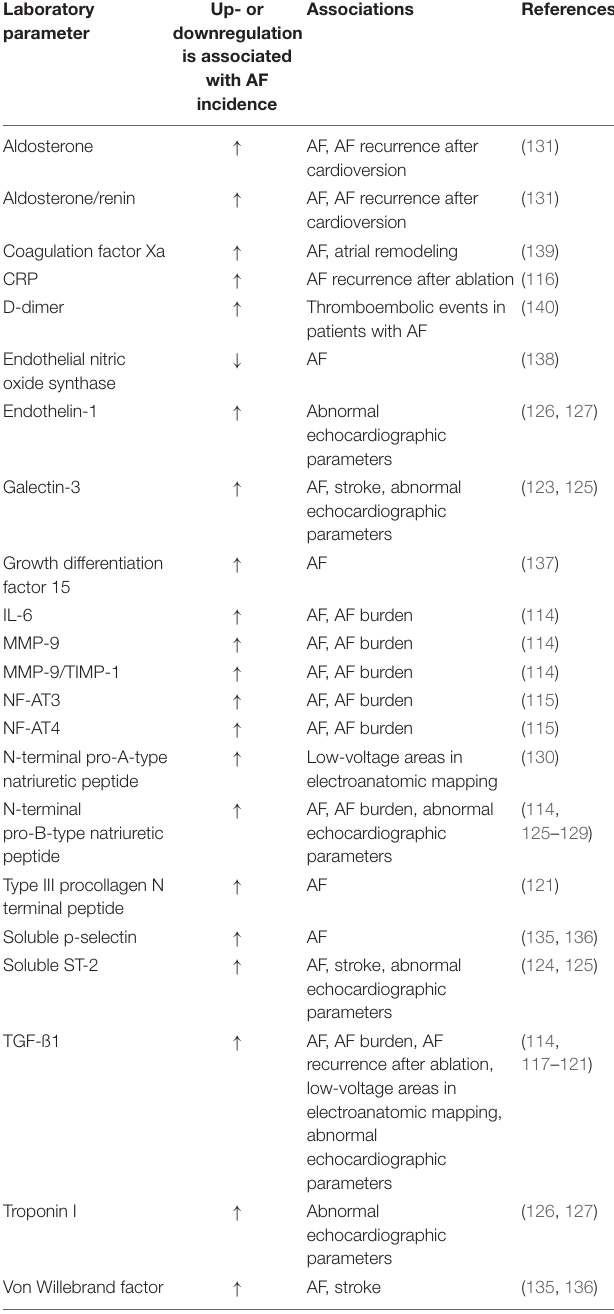
TABLE 2 | Overview of selected biomarkers with association to LACM, AF, and thromboembolic